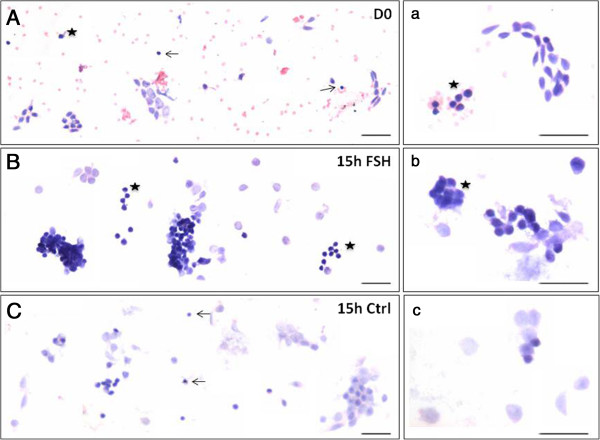
Effect of FSH treatment on sheep ovary surface epithelium (OSE) smears. (A, a) Freshly prepared sheep OSE smear after H & E staining. Epithelial cells (spindle shaped cells with pale nuclei and abundant cytoplasm) and distinct populations of putative stem cells including the VSELs (arrow) and OGSCs (asterisk) are evident along with red blood cells (RBCs) (B, b) Note the increase in number of stem cells and germ cell ‘cysts’ after 15 hrs of FSH treatment. The nests represent rapid stem cells clonal expansion with incomplete cytokinesis and characteristic of the OGSCs (C, c) OSE smear after 15 hrs culture without FSH. These observations were made in more than three different experiments. Note absence of stem cells activity. Epithelial cells after 15 hrs culture (B, b, C, c) appear similar and relatively bigger in size compared to the epithelial cells in fresh OSE (A, a). Scale bar represents 20 μm.